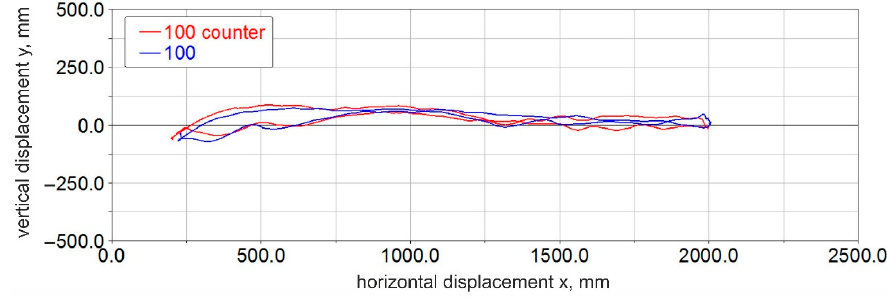
Figure 10. Manipulator’s effector trajectories for a velocity of 100 mm/s.